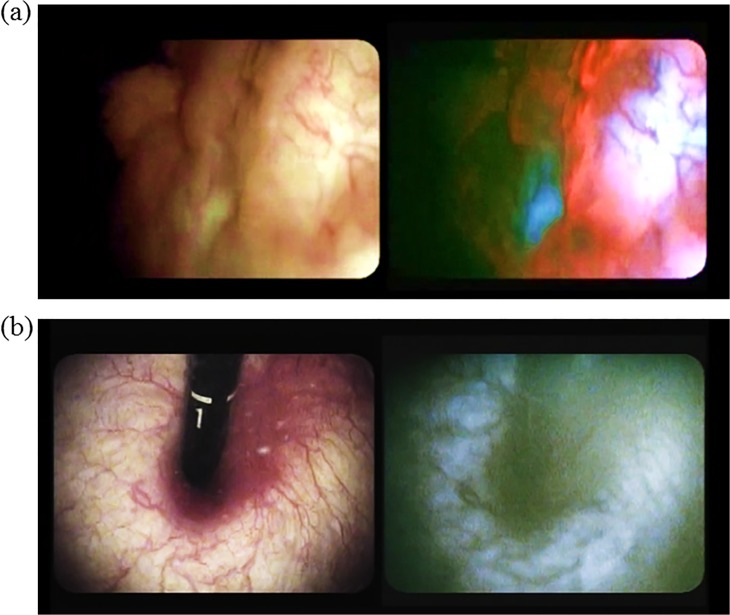
Cystoscopic findings in bladder tumors.(a) White light mode (left side) and blue light mode (right side) images of bladder cancer simultaneously observed using a twin mode monitor. Flat lesions showed red fluorescence. (b) White light mode (left side) and blue light mode (right side) images of the bladder neck using turned back flexible cystoscopy in a vertical direction. No red fluorescence was observed.